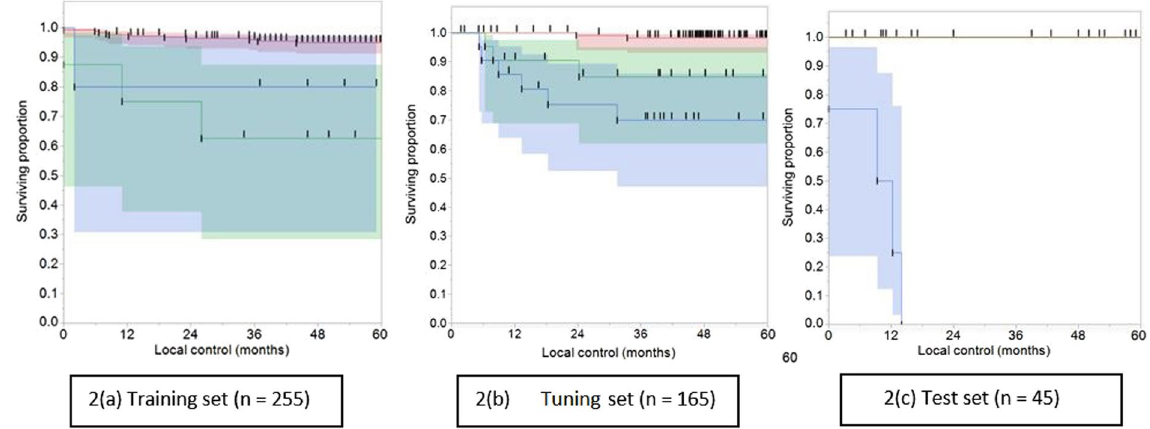
Figure 2. Local tumor control by permutations of radiomics-based image features combination. Kaplan- Meier curve showing local control (in months) for patients classified against different values. (Intensity Direct LRM = Intensity Direct Local Range Max, NID2.5 Complexity = Neighbor Intensity Difference 2.5 Complexity)